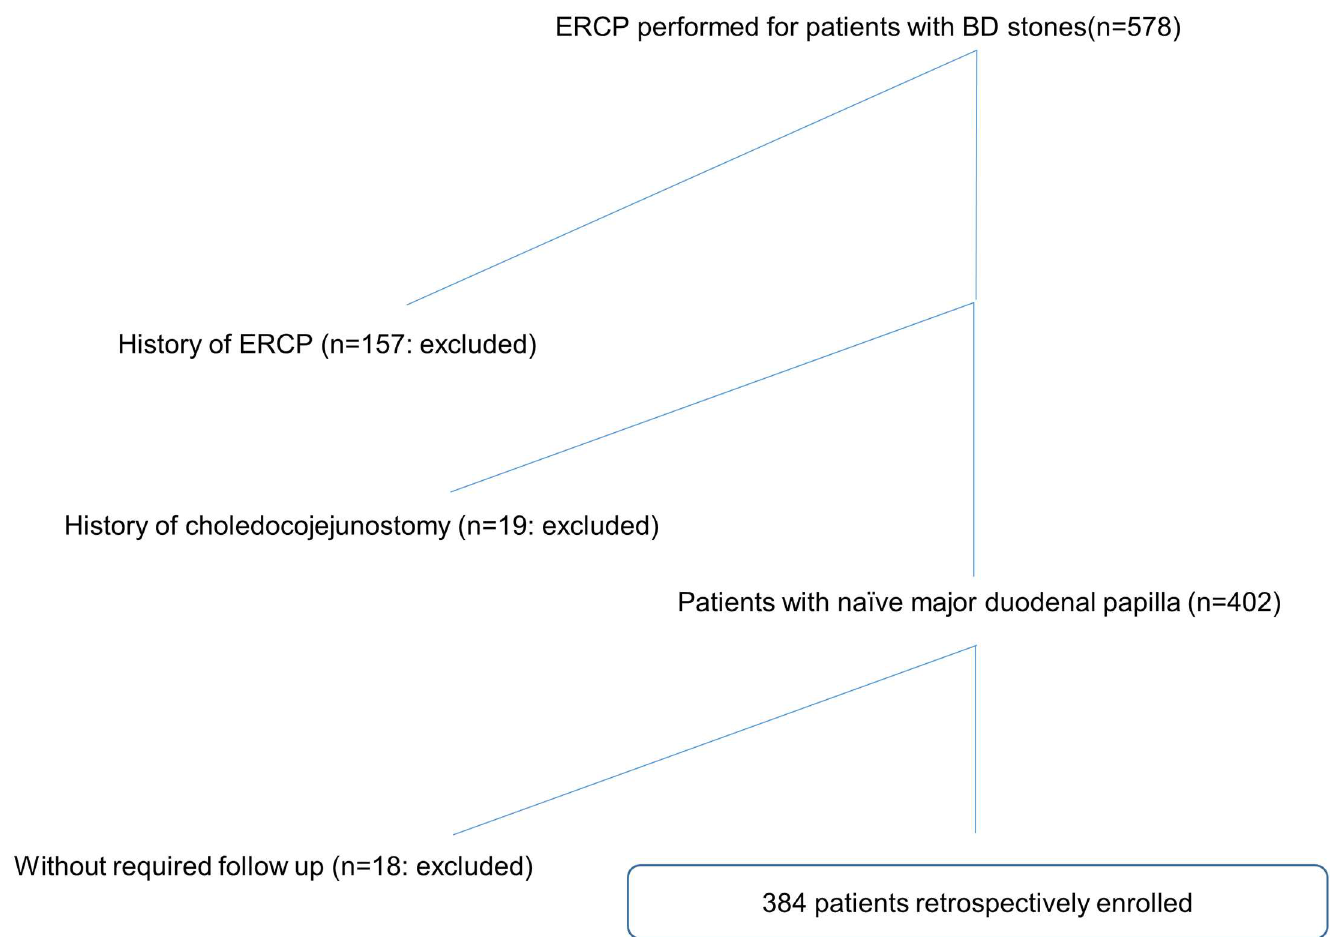
Fig 1. Enrollment flowchart. Among 578 patients who underwent ERCP for BD stone extraction, 194 patients were excludedand finally 384 patients were enrolled.